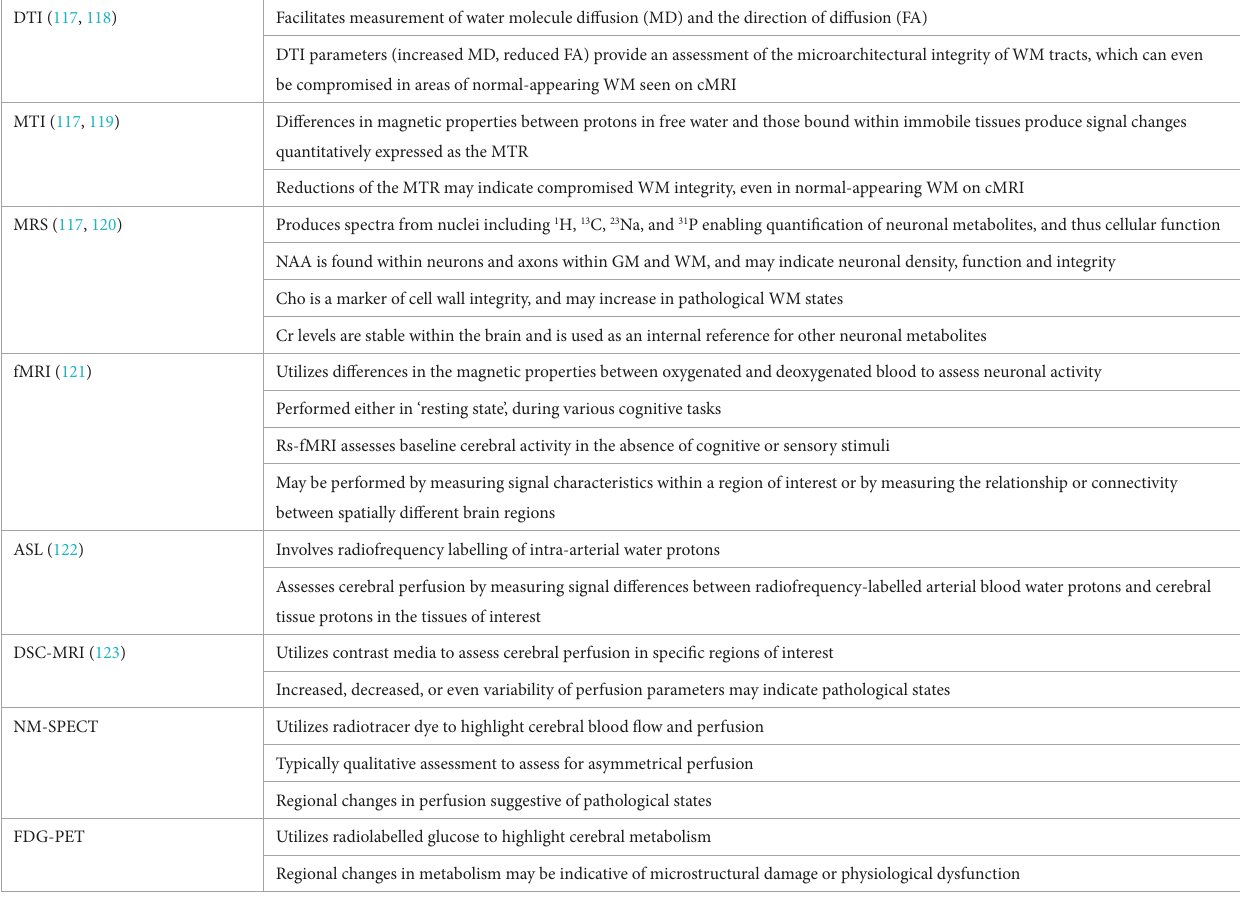
TABLE 3 Novel neuroimaging studies in